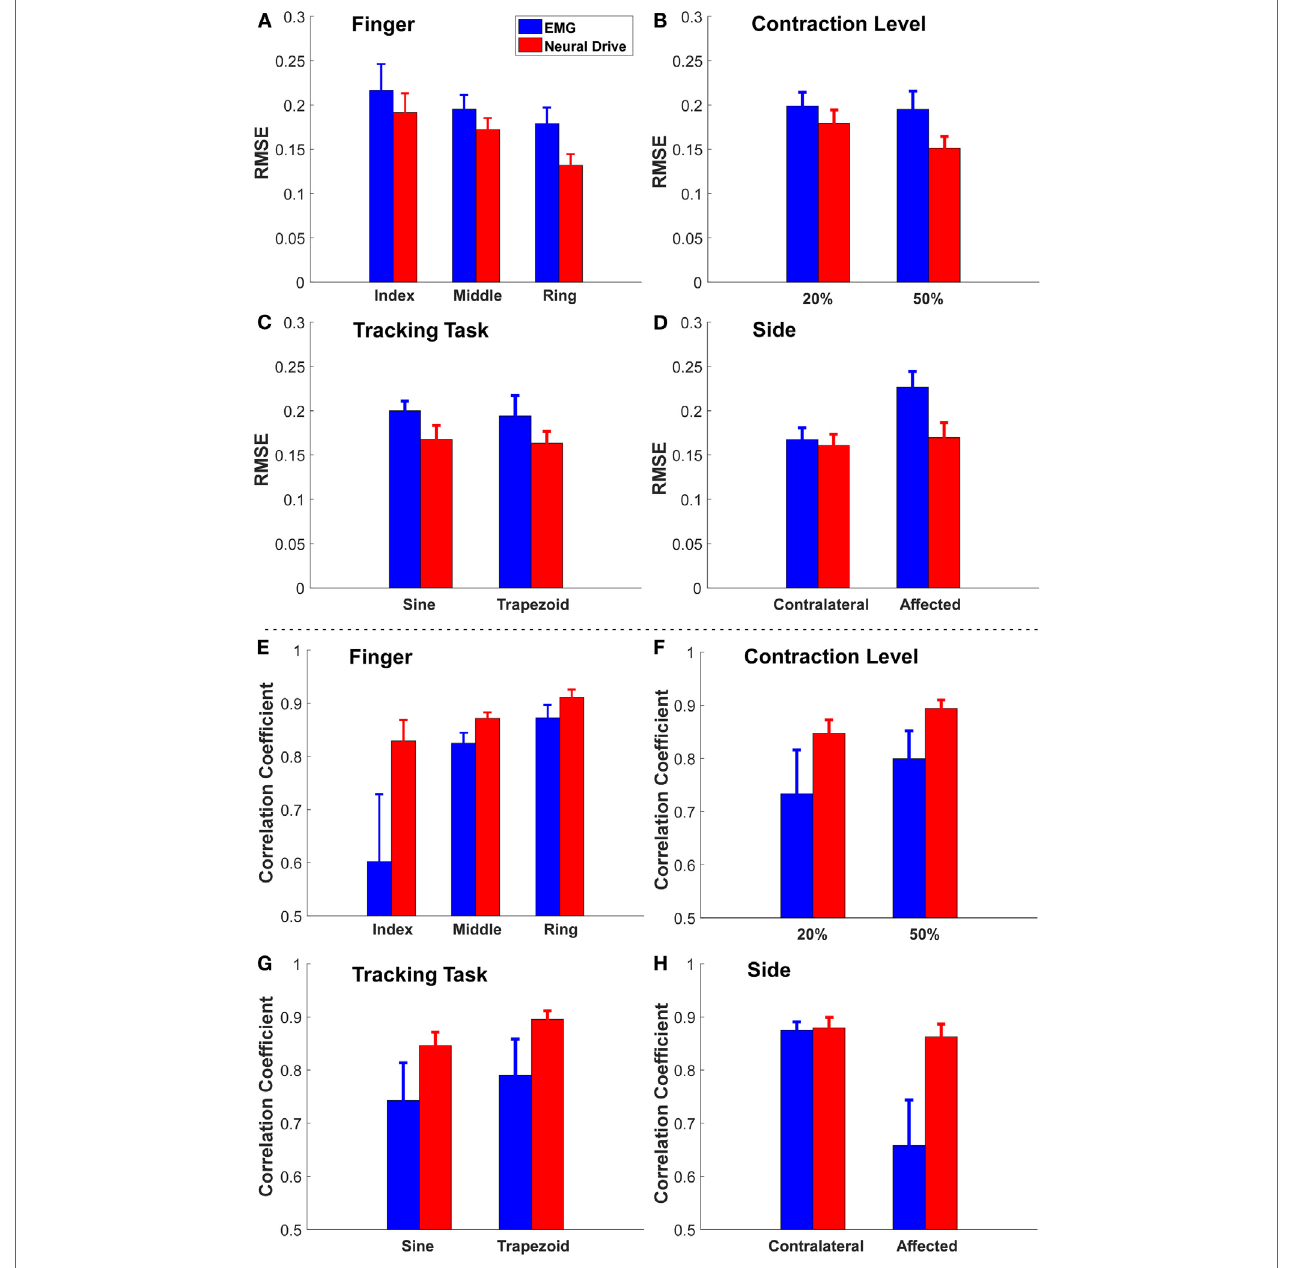
FIgURe 3 | The grand mean ± SE value of RMSE and correlation coefficient of each factor [ (a,e) finger, (B,F) contraction level, (C,g) tracking task, and (D,H) side]. The error bars represent the SE.